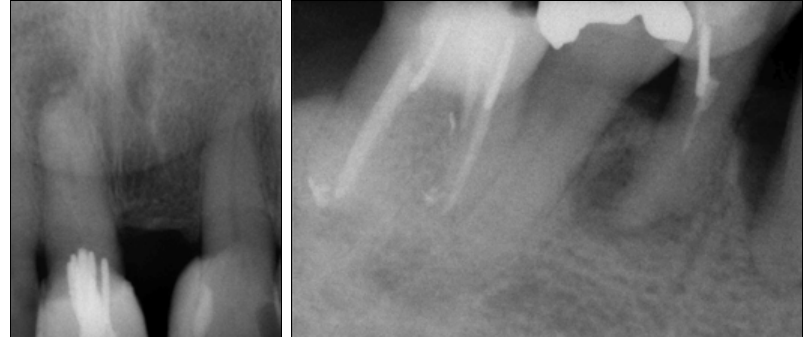
Figure 2. Periapical radiographs demonstrate periapical infections associated with the 11 and 44.